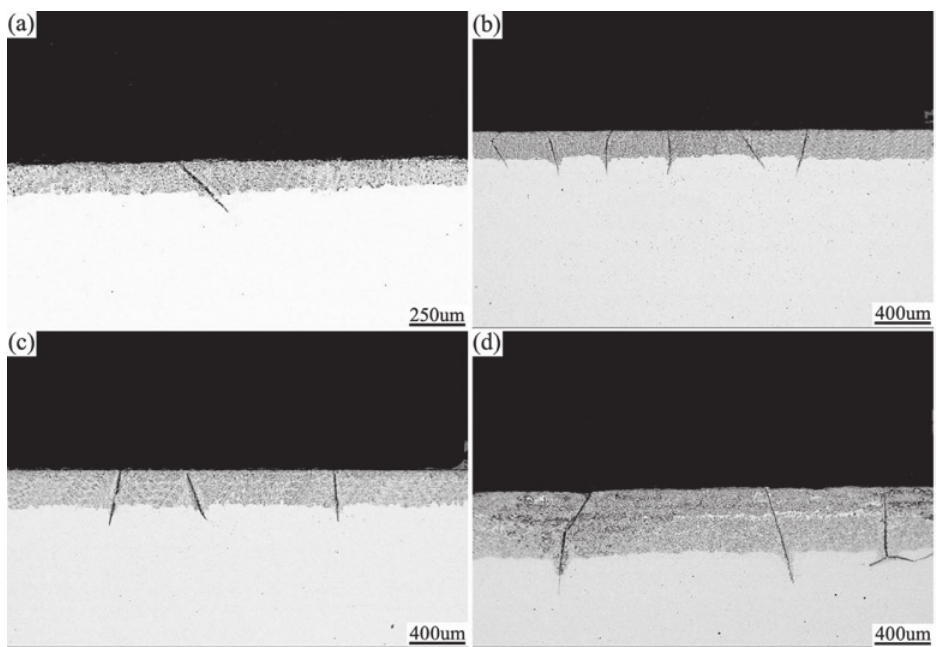
Fig. 7: Relationships between the thickness of the scales and the oxidation